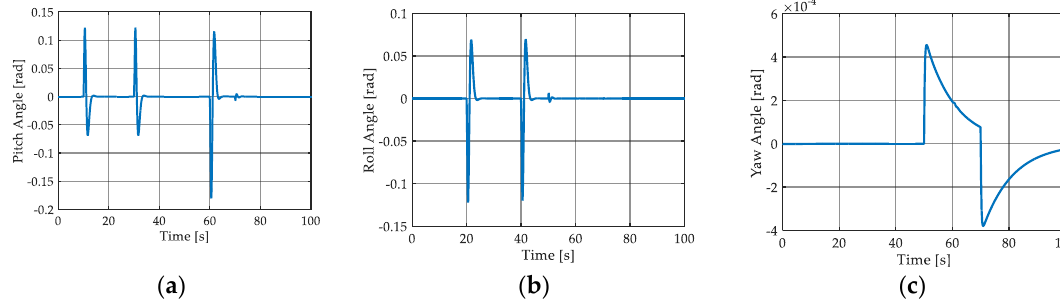
Figure 8. Tracking performance of Euler angles: ( a ) Pitch angle; ( b ) roll angle; ( c ) yaw angle.